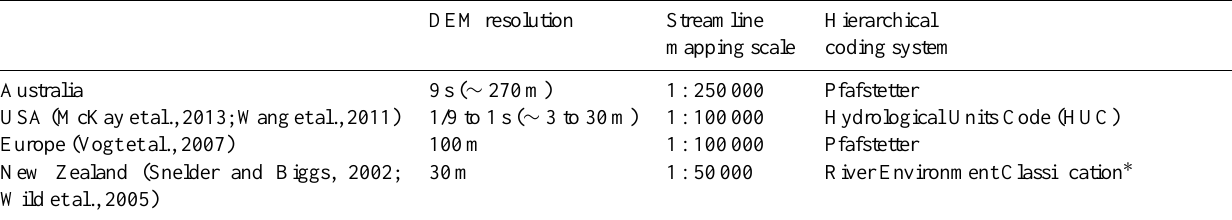
Table 5. A comparison of the new Australian stream and catchment framework with comparable international examples.